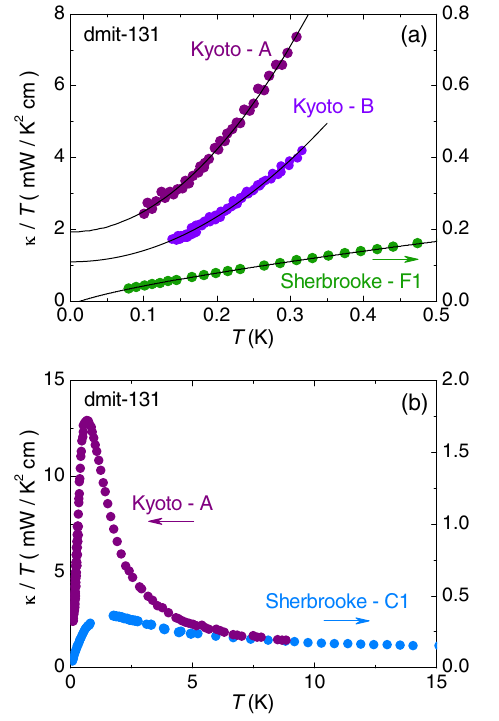
FIG. 4. (a) κ =T vs T for our sample F1 (green, right scale) and for samples A (purple) and B (violet) of Ref. [10] (left scale). Note that the left and right vertical scales differ by a factor 10. The three samples were grown in identical conditions, using the same starting material. For our data, the black line is the free power-law fit below 0.55 K shown in Fig. 2. For the Kyoto data, the lines are quadratic fits reproduced from Ref. [10]. (b) κ =T vs T up to 15 K for our sample C1 (blue, right scale) and for sample A of Ref. [10] (purple, left scale). Note that the left and right vertical scales differ by a factor